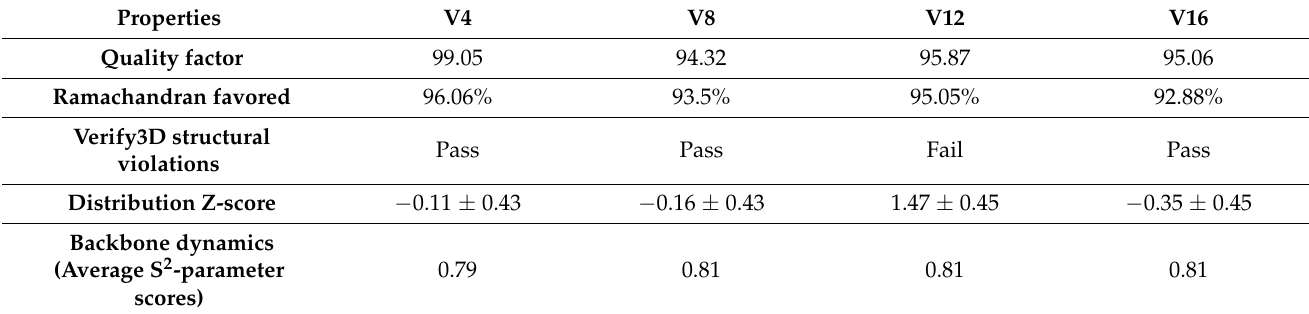
Table 7. Structural quality comparison of the modelled vaccine